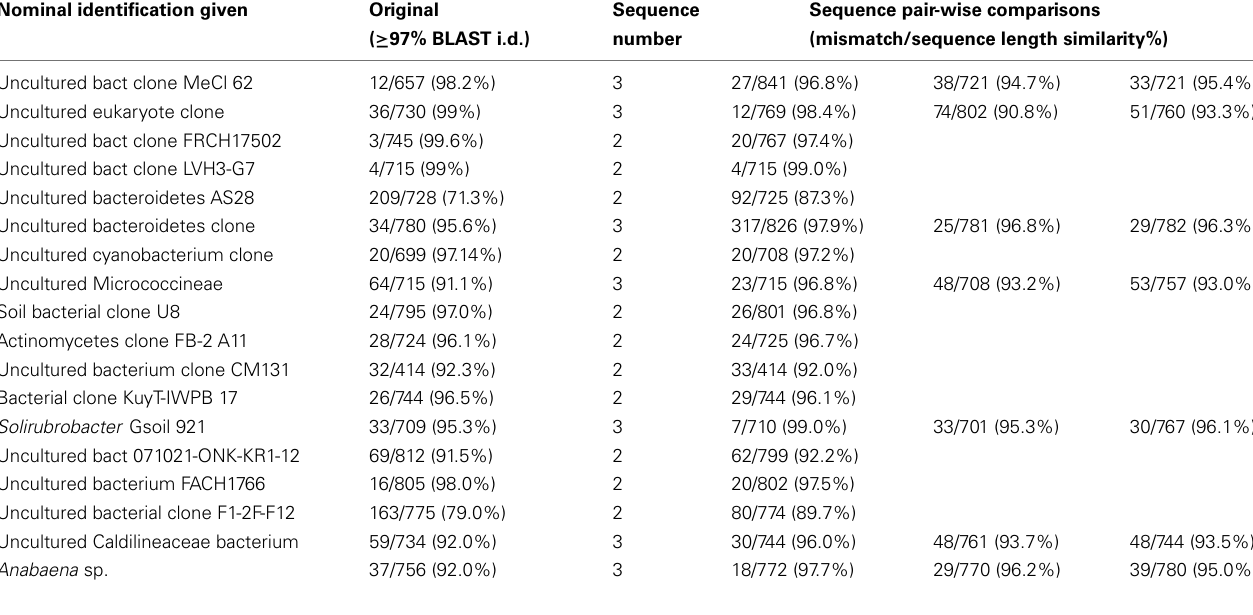
Table 4 | Mars Oasis clone library